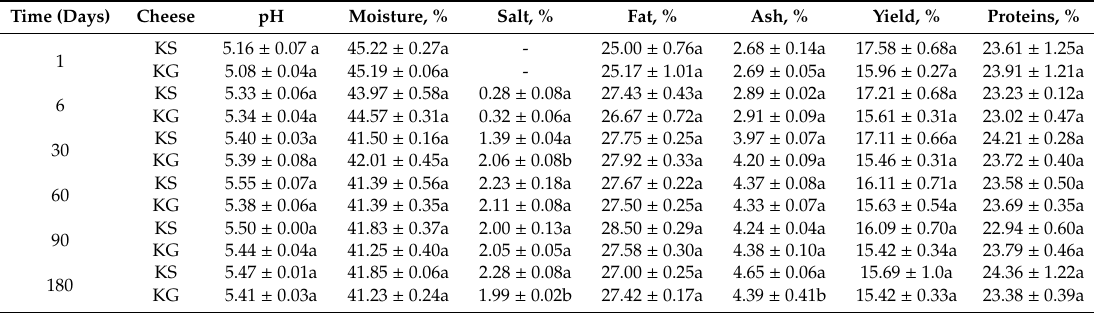
Table 1. Changes of physicochemical characteristics of kashkaval of Pindos cheese made from